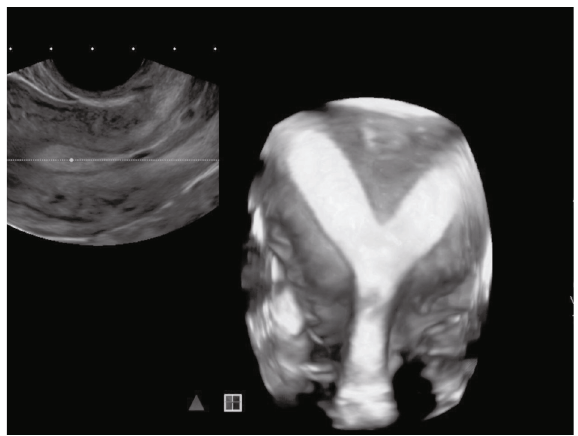
Figure 1: 3D transvaginal ultrasound prior to conception demonstrates a large uterine septum. There is no fundal indentation seen.